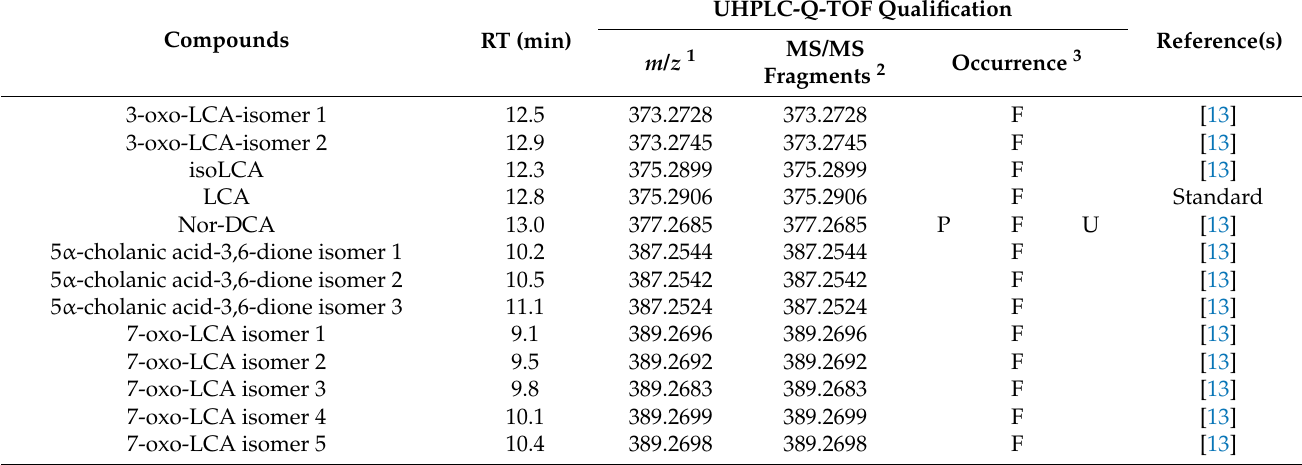
Table 1. Tentative identification of bile acid species in human biological samples using UHPLC-Q-TOF. UHPLC-Q-TOF Compounds RT (min)